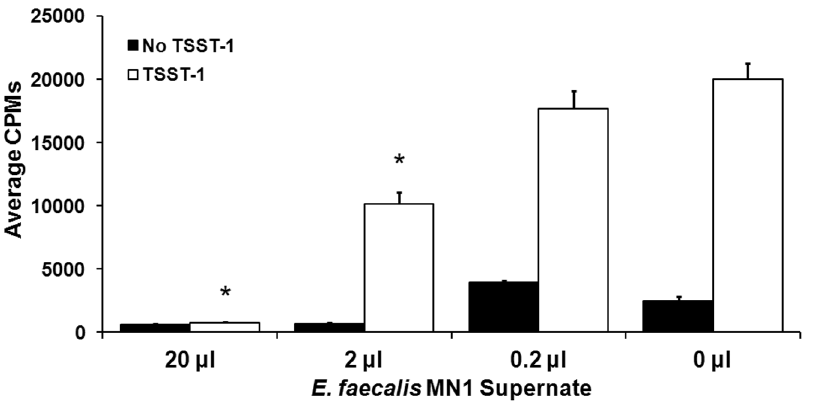
Figure 7. E.faecalis MN1 supernate inhibits TSST-1-induced T cell proliferation. E. faecalis MN1 supernate was incubated with human PBMCs and TSST-1 (1 m g/well) in a superantigenicity assay to assess the ability of secreted factors to inhibit TSST-1-induced T cell proliferation. The two highest doses of supernate (20 and 2 m l per well) significantly inhibited T cell proliferation due to TSST-1 by individual Student’s t tests (*p , 0.001). The 0 m l control shows the average CPMs for PBMCs with and without TSST-1.